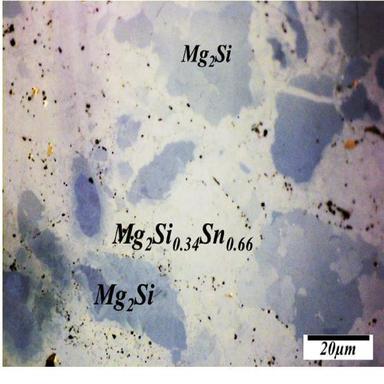
Optical micrographs of: a) MnSi1.77 and b) Mg2Si0.6Sn0.4.